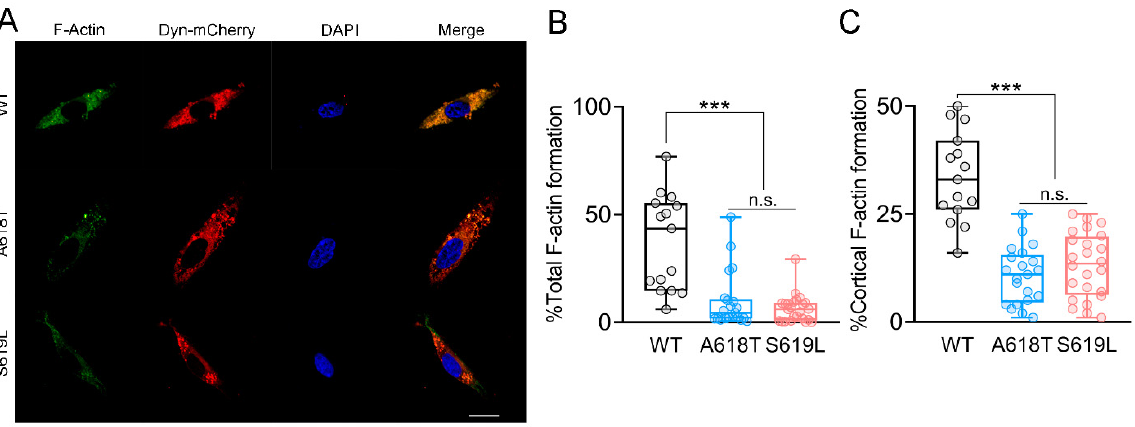
Figure 5. Actin filament formation in human myoblasts overexpressing WT dynamin-2 or expressing the p.A618T or the p.S619L mutations. C25 cells transfected with WT, p.A618T or p.S619L dynamin-2-mCherry plasmids were permeabilized with 20 µ M digitonin in a KGEP buffer containing 2 mM ATP-Mg 2+ , 10 µ M free Ca 2+ and 300 nM Alexa-Fluor-488 actin for 6 min at 37 ◦ C. After fixation, images were acquired at the equatorial plane of the cells by confocal microscopy using identical exposure settings for all cells. Panel ( A ) shows representative cells expressing de novo F-actin filaments (green), WT, p.A618T or p.S619L dynamin-2 (red) and the nuclear marker DAPI (blue). Scale bar = 20 µ m. ( B , C ) Quantification of the fluorescence intensity of Alexa-Fluor-488 actin in the whole cytosol ( B ) and the cortical area ( C ). Data are expressed as the percentage of fluorescence area divided by the total cell area without nucleus area ( B ) or by the cell cortex area ( C ), according to described in methods. Horizontal lines and whiskers in box plots indicate medians and min (bottom) and max (top) values of the distribution. *** p < 0.001 compared to the WT condition (Kruskal–Wallis test followed by Dunn’s multiple comparison test). n.s., non-significant difference.